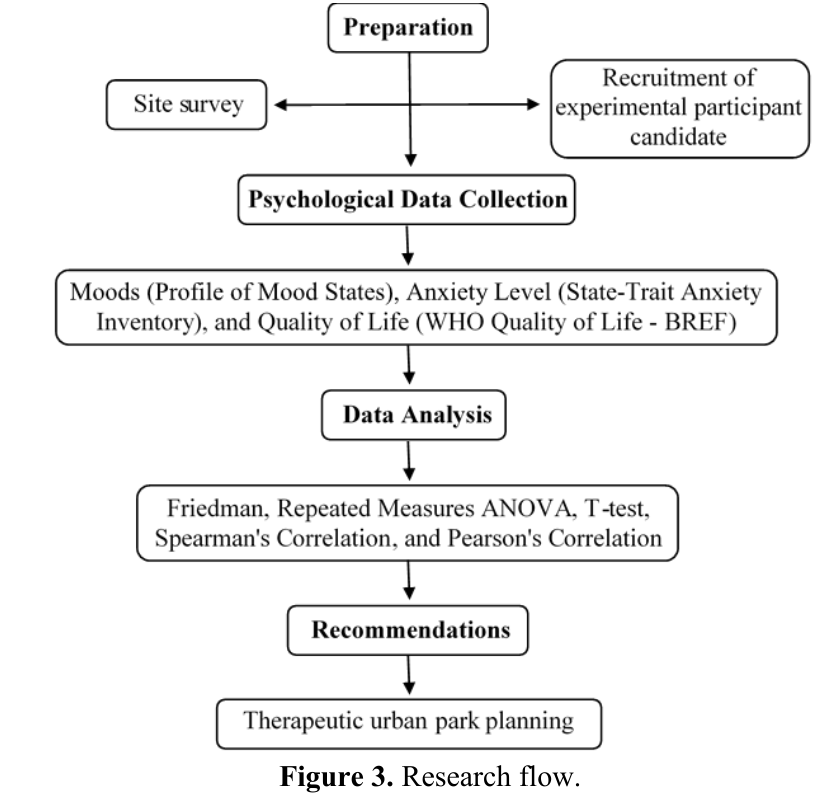
Figure 3. Research